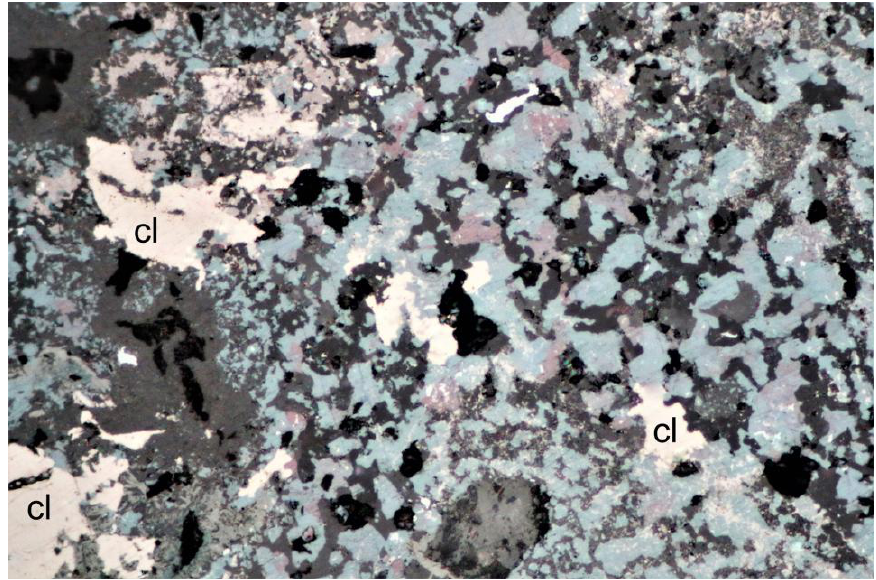
Figure 13. Clausthalite (cl) partly replaced by end-member krut’aite (blue), end-member petříčekite (blue-violet), molybdomenite (dark grey), and native selenium (light grey), forming a myrmecitic texture [7]. Reflected light image, 500-μm-wide, plane polarized light.